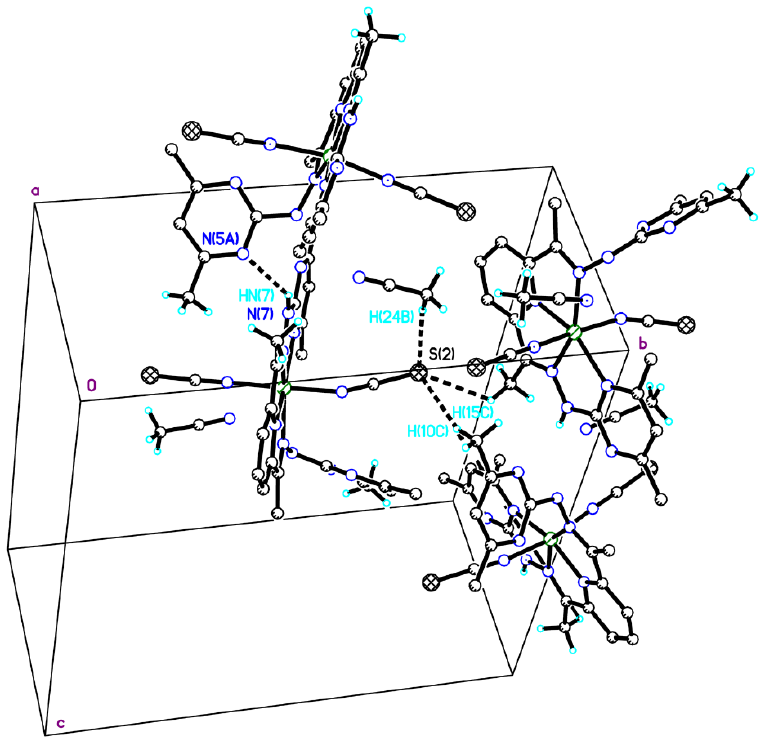
Figure 6. Fragment of the crystal packing of compound 4 (dotted lines indicate the the S(2) … H contact and the N(7)-H(N7) … N(5A) hydrogen bond) (a, b, c—crystallographic axes). The shortest distance between Ni(II) paramagnetic centers in the crystal structure is 8.476 Å. The coordination polyhedra of the metal coordination center are summarized in Figure 7, while the deviations of the donor nitrogen atoms of ligand L and metal center M from the equatorial plane (least-squares plane of atoms M, N(1), N(2), N(6)) are listed in Table 3.